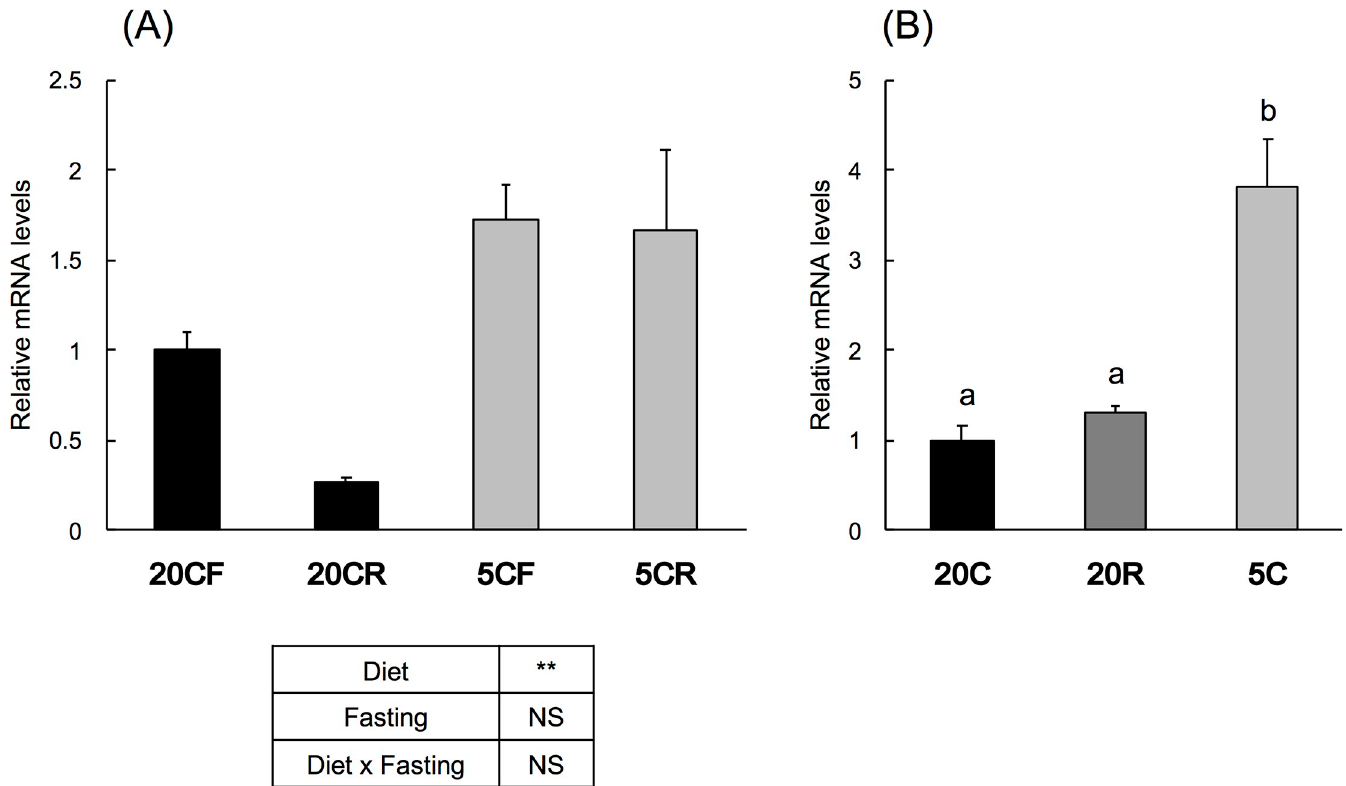
Fig 1. Effect of protein restriction on hepatic leptin receptor mRNA level in rats. (A) Rats were fed a control diet (20C) or a low-protein diet (5C) for 7 d and sacrificed after 12-h fasting (20CF, 5CF) or 12-h fasting followed by 12-h re-feeding (20CR, 5CR). Leptin receptor mRNA was measured by real-time PCR and results were expressed relative to that of 20CF, means ± standard errors (n = 5). Results of two-way ANOVA are given below the graph (NS, not significant; �� , p < 0.01). (B) Rats were fed a control diet ad libitum (20C), fed a low-protein diet ad libitum (5C), or pair-fed a control diet with 5C (20R) for 16 d. Ob-R mRNA was measured by real-time PCR and expressed as means ± standard errors (n = 5). Results with different alphabet are statistically different ( P < 0.05).